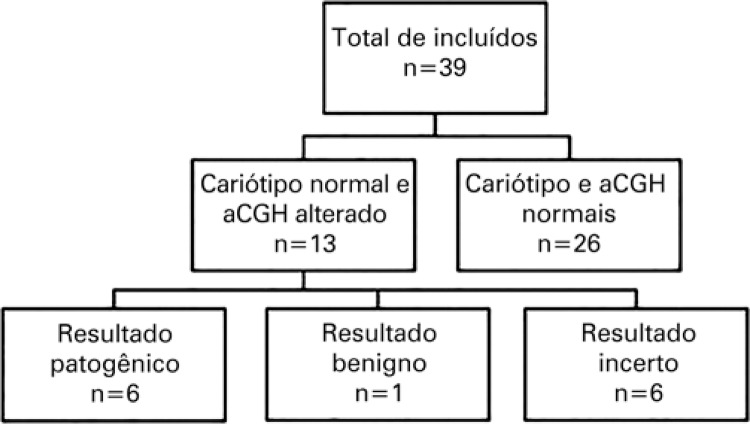
Fluxograma dos resultados obtidos pelas técnicas de cariótipo convencional e aCGH